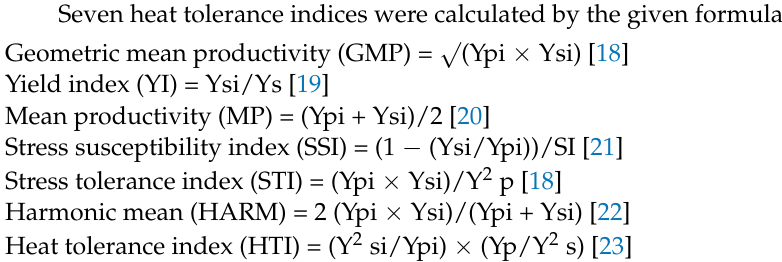
Table 3. Combined environment variance analysis of seed yield (kg/ha), broomrape infection (Oc/plant), and flowering